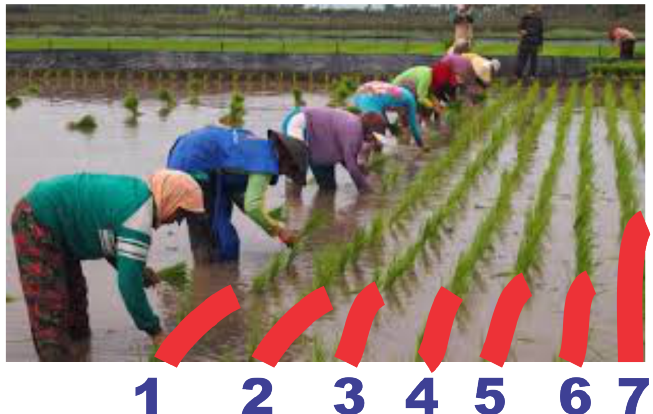
Fig. 3. Illustration of teamwork assessment Planting Rice Games with AI technology (Source Image: http://tribunnews.com